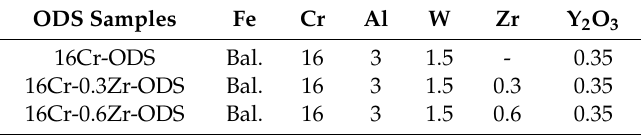
Table 1. Nominal composition (wt %) of the three ODS